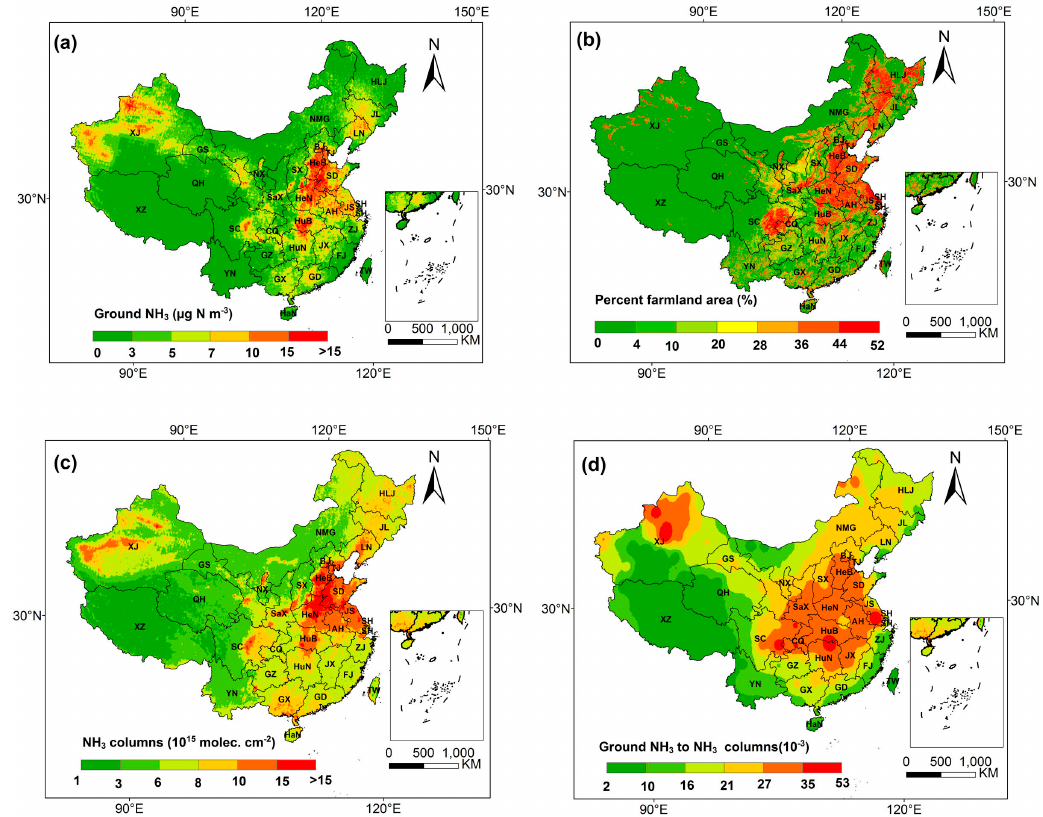
Figure 5. Spatial distribution of the ground NH 3 concentration ( µ g N m − 3 ). ( a ) represents the yearly estimated ground NH 3 concentrations; ( b ) denotes the percent farmland area; ( c ) denotes the Infrared Atmospheric Sounding Interferometer (IASI) NH 3 columns and ( d ) indicates the ratio of ground NH 3 concentration to NH 3 columns from MOZART.